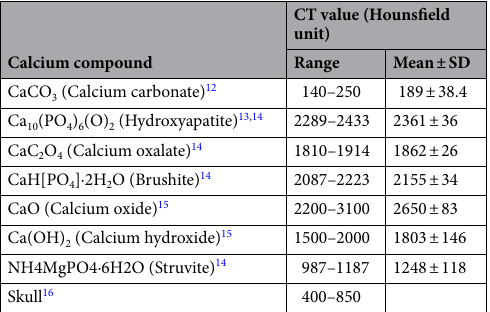
utricular macula. Figure 3 showed a posterior view of the vestibular coronal section created from the same case as Fig. 2. The saccular macula was bud-shaped and the origin was a trapezoidal shape. The utricular macula was thin and irregularly shaped along the upper vestibular wall. From these cases, the shape and volume of the normal case were different for each subject. Clinical imaging of the otolith organs. Benign paroxysmal positional vertigo (BPPV) in a 25‑year‑old female. In the axial vestibular cut view from the parietal of Fig. 4, the irregularly shaped utricular macula was seen as gray tissue extending from near the exit of the superior semicircular canal to the exit of part of the common crus. In the parasagittal vestibular view from the external auditory canal in Fig. 5, the utricular macula became thick and hill-shaped, a small grayish mass was observed from the exit to the body of the common crus. The posterior crista ampullaris was spindle-shaped. The volume and shape of the saccular macula and the crista ampullaris showed almost the same as the normal ones. The same gray tissue was detected in the cerebellopon- tine angle cistern as in the